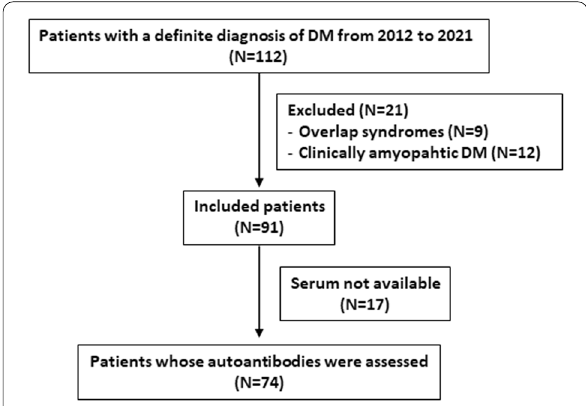
Fig. 1 Flowchart of selection of the patients with dermatomyositis from the present